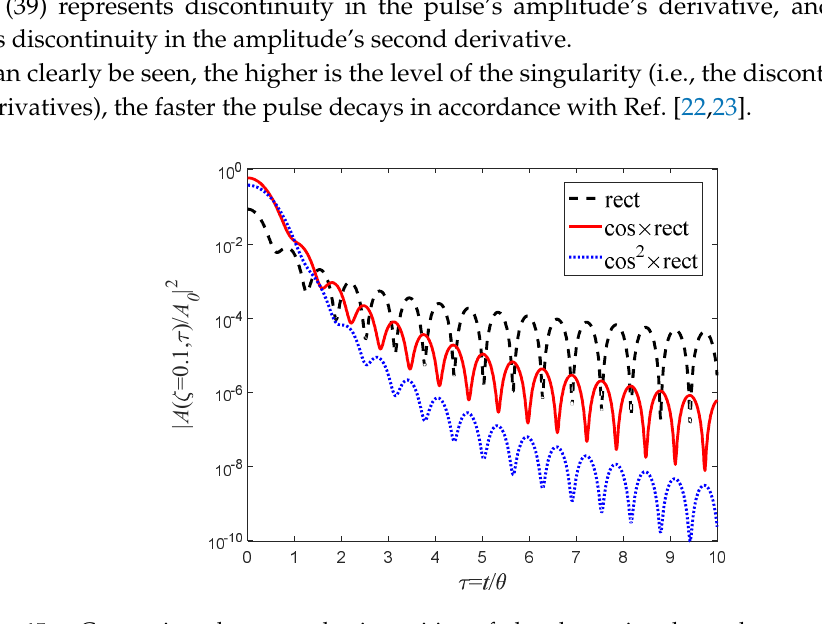
Figure 15. Comparison between the intensities of the three singular pulses represented by Equation (27)—dashed curve, Equation (39)—solid curve, and Equation (42)—dotted curve in a logarithmic scale.